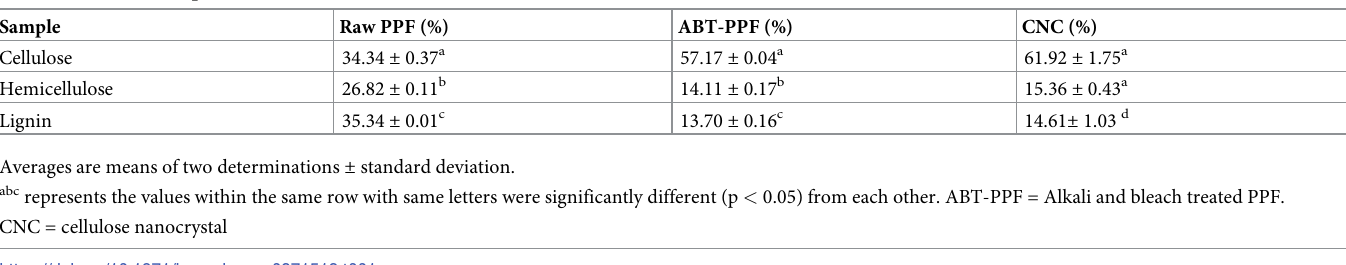
Table 1. Chemical compositions of Raw PPF and ABT-PPF.